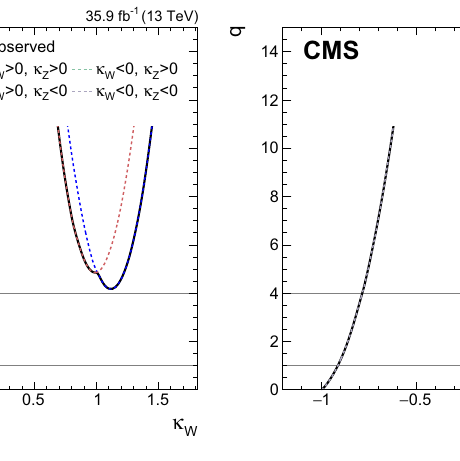
minimum value of q (κ W ) in each case and is used to determine the best fit point and the 1 σ and 2 σ CL regions. The scan in the right figure is truncated because of the constraints of | κ W | ≤ 1 and | κ Z | ≤ 1, which are imposed in this model